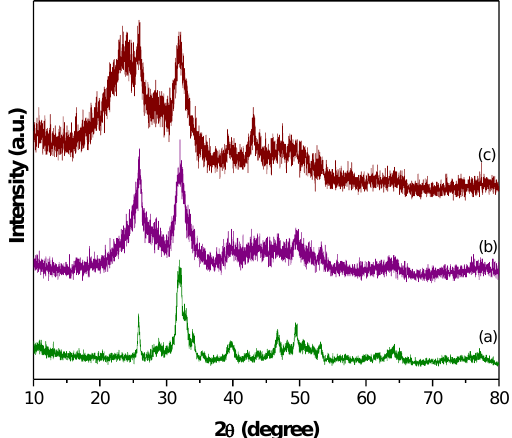
Figure 1. XRD pattern of (a) HAP, (b) CNTs-HAP, and (c) GR-HAP.